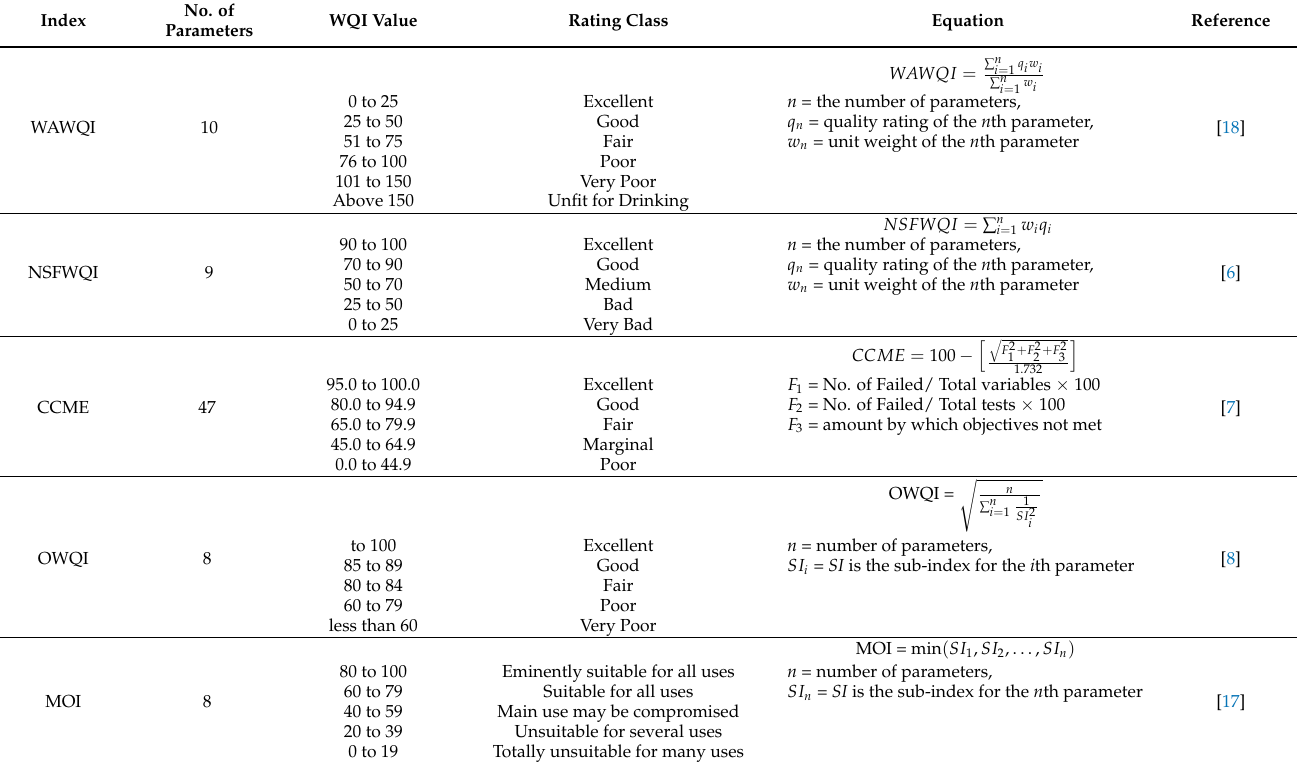
Table 1. Classification of WQI values for five